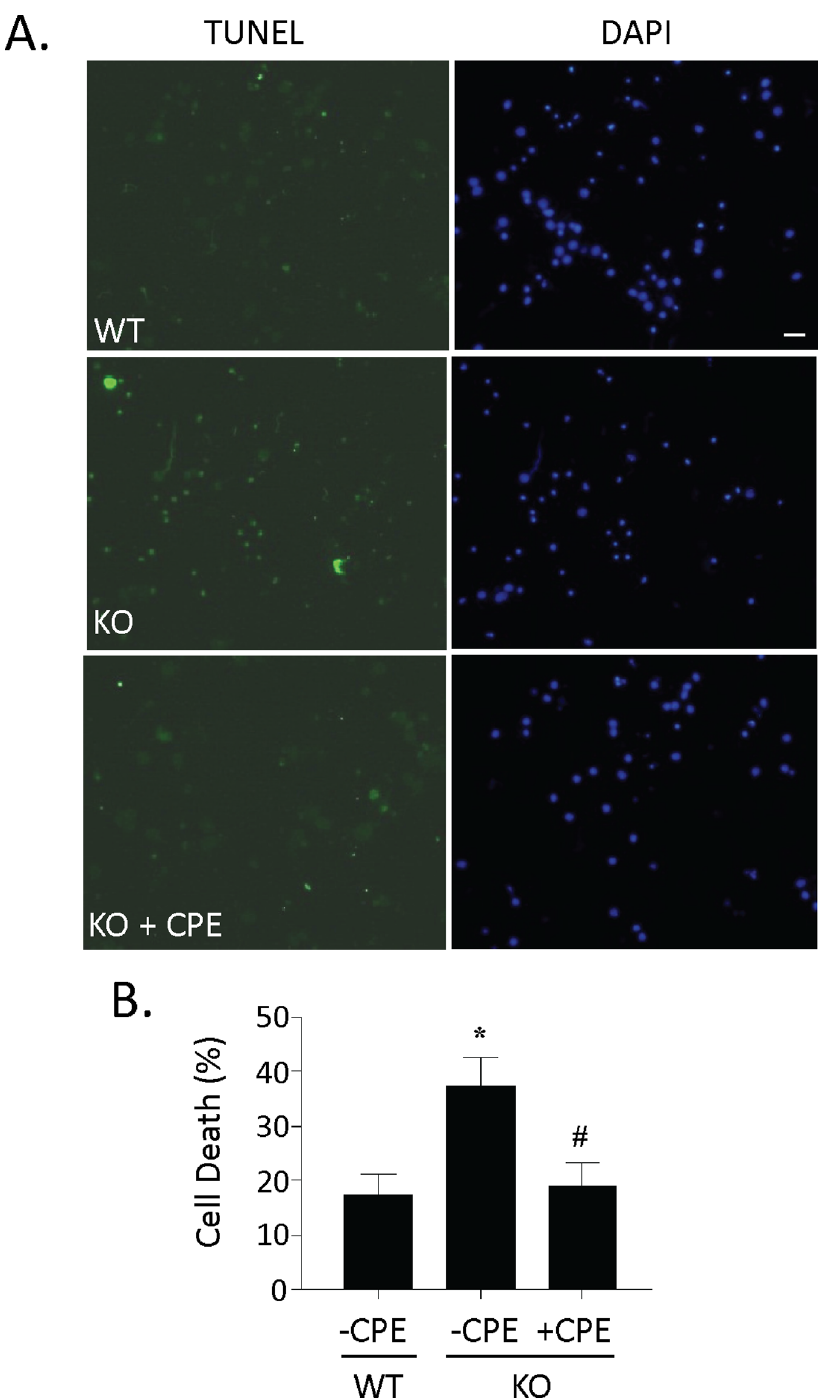
Figure 3. Purified recombinant CPE rescues cell death in CPE knock-out mouse hippocampal neurons. A) Photomicrographs of 2 week cultures of hippocampal neurons derived from WT and CPE-KO embryos stained by TUNEL (green) and DAPI (blue). Note the higher number of dead cells (green) in the CPE-KO culture (KO) compared to the WT culture (WT). Culturing the CPE-KO neurons in the presence of 0.4 m M CPE significantly reduced the number of dead cells (KO + CPE). B) The bar graph represents the quantification of the dead cells as a % of the total number of cells determined by the DAPI staining. Students t test, n=4, *p , 0.05 compared to WT neurons; # p , 0.05 compared to KO neurons not treated with CPE. Bar=100 m